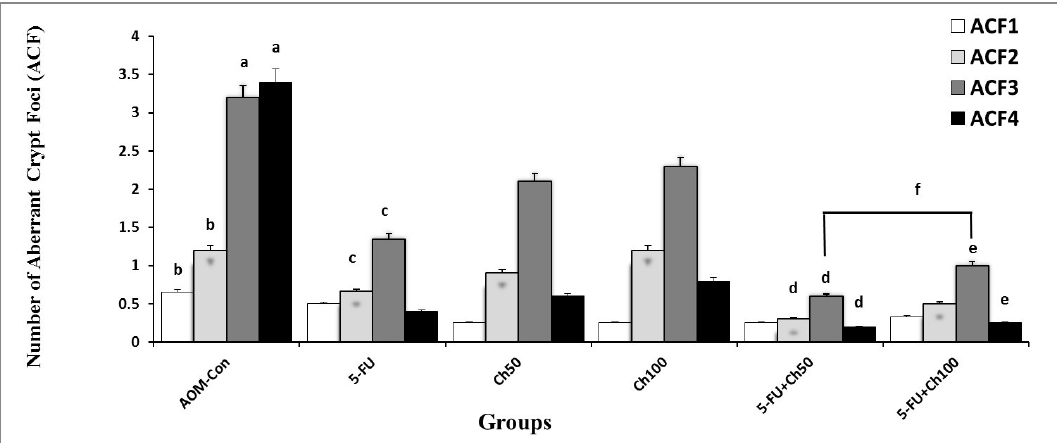
FIGURE 2 - The effects of 5-FU and chrysin and their combined treatments on the aberrant crypt foci (ACF) formation of the distal colon region in mice receiving azoxymethane. Significance level was p <0.05. ACF1 = crypt with grade 1, ACF2 = crypt with grade 2, ACF3 = crypt with grade3, ACF4 = crypt with grade4. a: versus all treated groups, b: versus Ch50 + 5-FU and Ch100 + 5-FU, c: versus Ch100, d: versus Ch50, 5-FU and Ch100, e: versus Ch50, 5-FU and Ch100 groups, f: Significant difference of ACF3 between 5-FU + Ch50 and 5-FU +